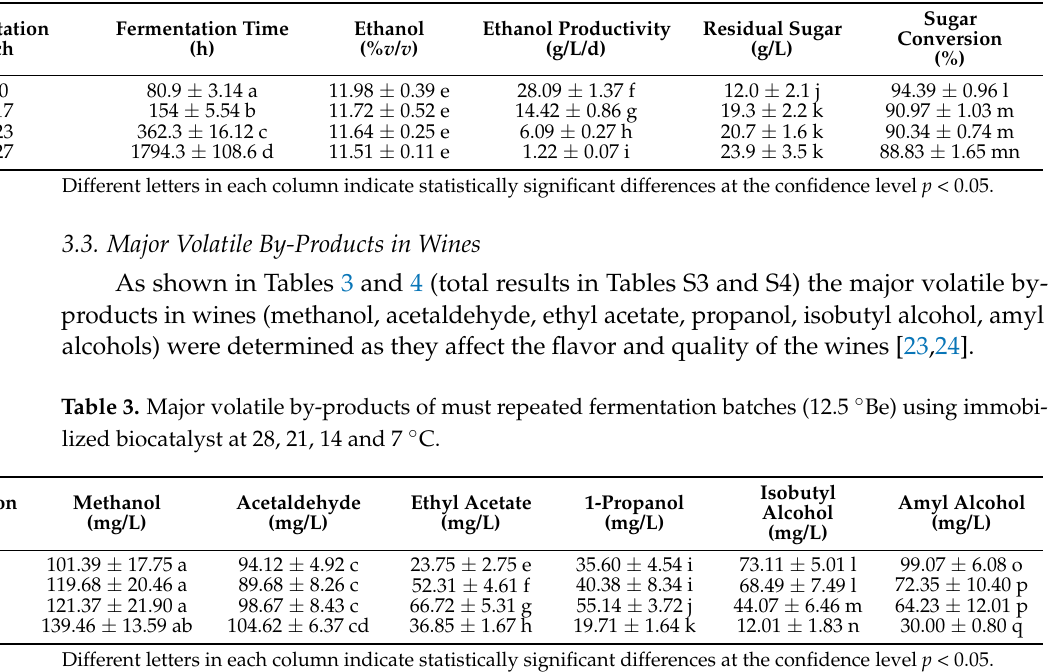
Table 2. Kinetic parameters of must repeated fermentation batches (12.5 ◦ Be) using immobilized biocatalyst at 28, 21, 14 and 7 ◦ C.